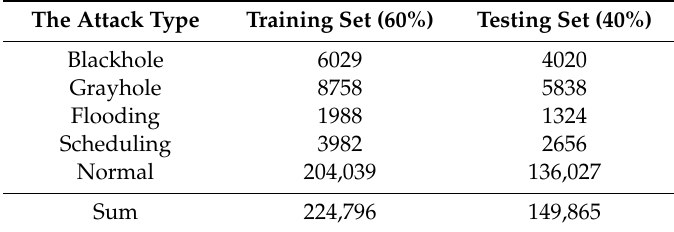
Table 3. The dataset separated 60% training set and 40% testing set using holdout method.